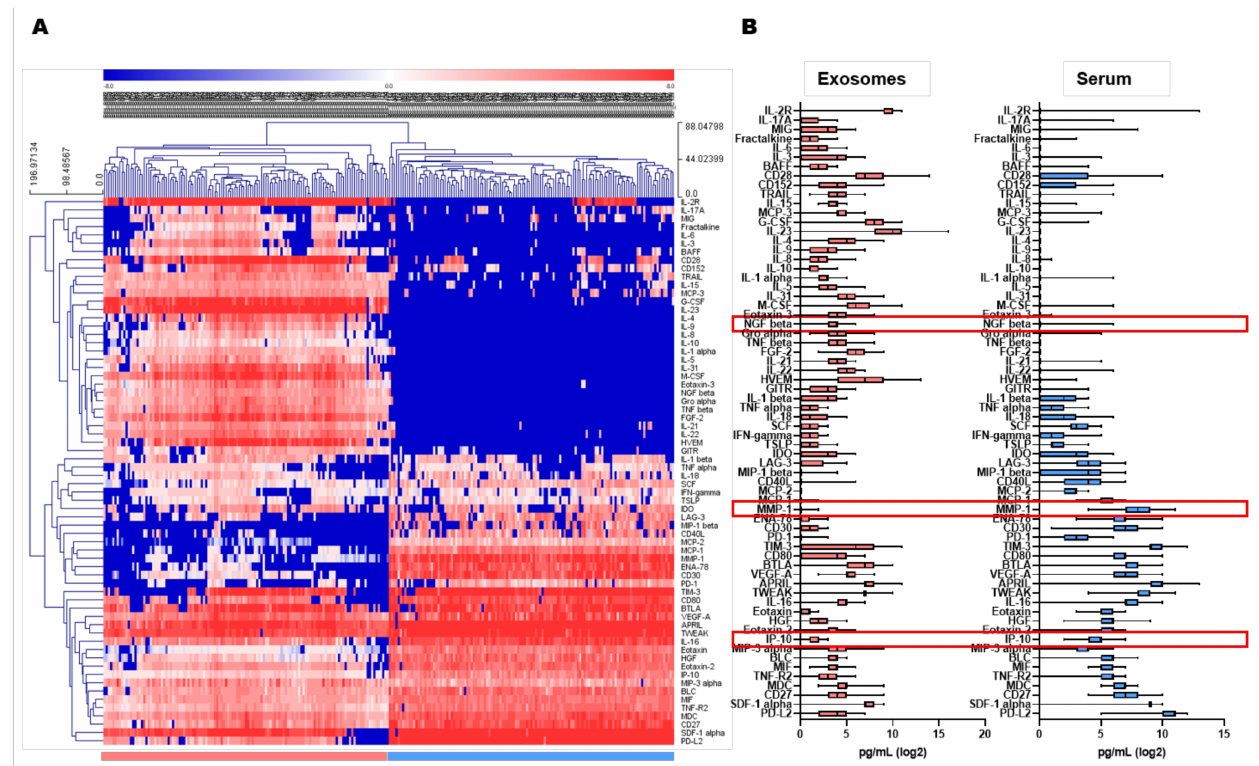
Figure 2. Comparisons of biomarker expression in serum and exosomes by multiplex assay. ( A ) Heat map demonstrating unsupervised hierarchical clustering of samples, generated with Multi-Experiment Viewer (MeV v4.9). ( B ) Box plot demonstrating mean expressions of biomarkers in serum and